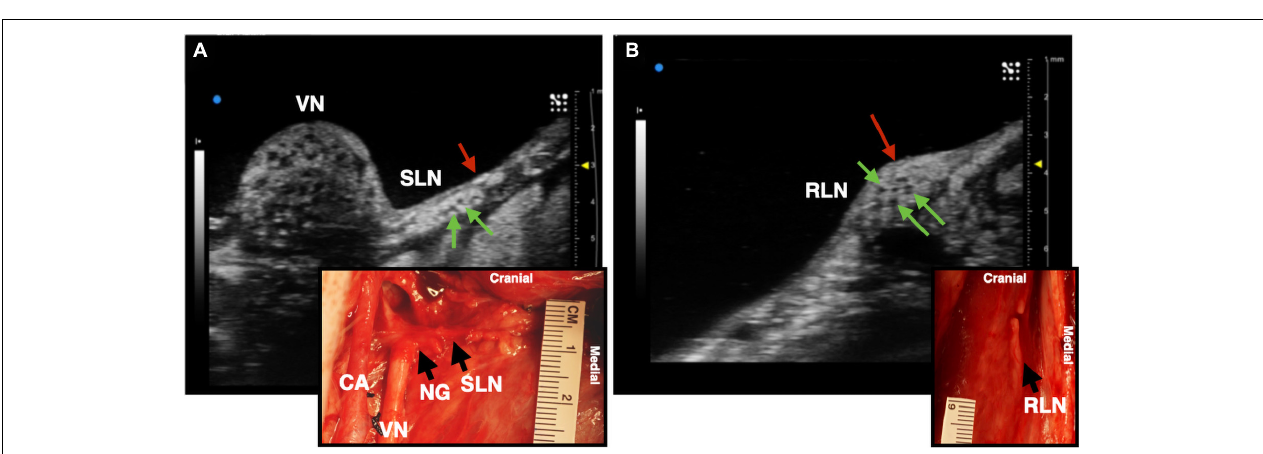
FIGURE 3 | Comparison of ultrasound in live (A) and cadaver (B) swine. Insets are demonstrating clear visualization of fascicles in both states.